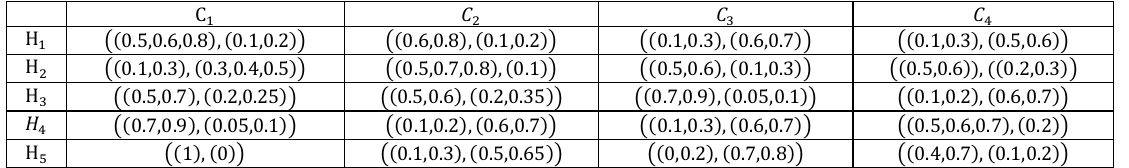
Table 2. Expert’s review about the schools is represented as intuitionistic hesitant fuzzy